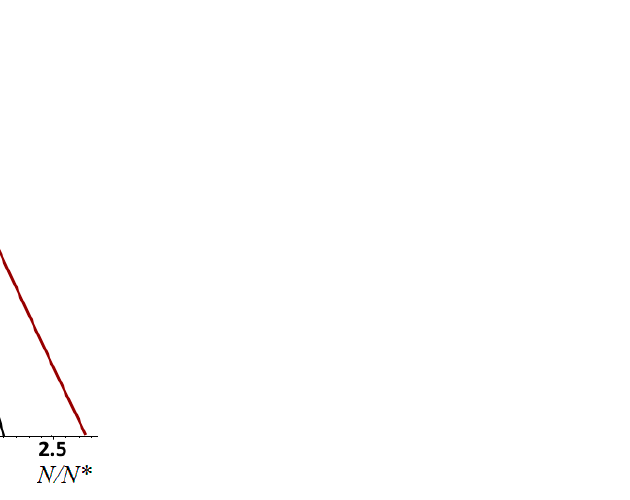
amplitude of nominal pressure was constant (curve 1) or varied by ± 20% (curve 2) or ± 80% (curve 3). ν = 0.4, p n (cid:48) = 4.2 · 10 − 2 , h (cid:48) = 0.667, V (cid:48) =